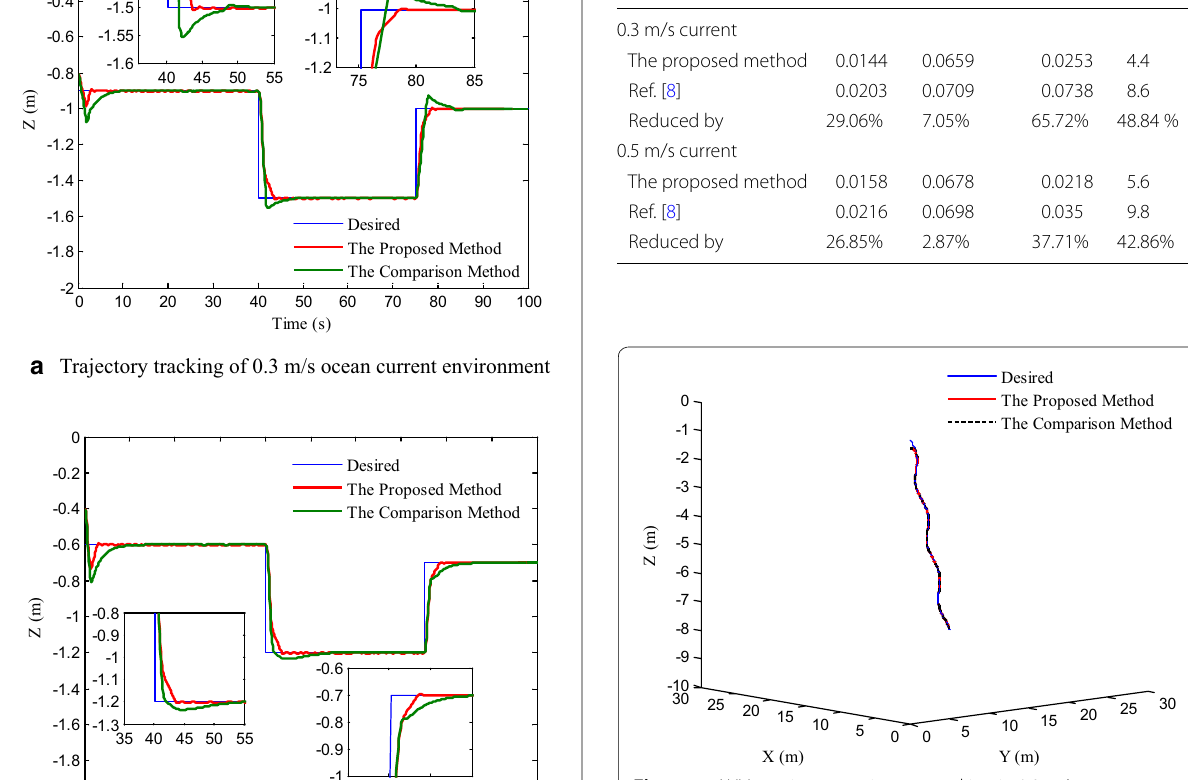
Figure 4 AUV continuous trajectory tracking in 0.3 m/s ocean current